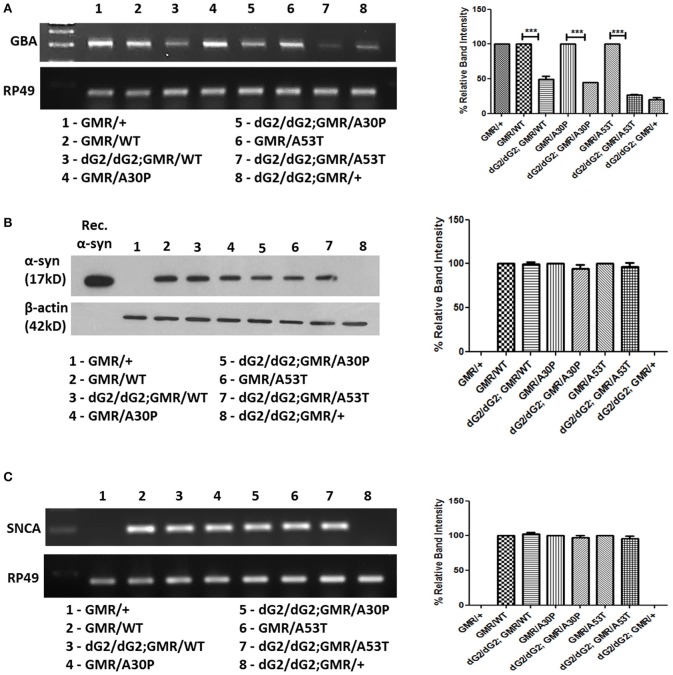
Absence of transcriptional changes in α-syn expression in dG2/dG2 RNAi flies. (A) RT-PCR confirms knockdown of GBA1 mRNA in flies with dG2/dG2 (in presence/absence of α-syn-WT, A30P, A53T) with single copy of GMR-Gal4 driver compared to respective control flies. This confirms significant transcriptional downregulation of GBA even in the absence of eye phenotype (in flies with single copy of GMR). Corresponding densitometric analysis of RT-PCR was done by normalizing controls to 100% and experimental flies (dG2/dG2 with/without α-syn) are compared against their respective controls. (B) The effect of GBA silencing on α-syn protein expression, immunoblotting was done by whole tissue lysis extraction method. Further densitometric analysis revealed no change in α-syn protein level in flies with dG2/dG2 expressing α-syn (WT, A30P, and A53T) under GMR-Gal4 drive compared to control flies expressing α-syn (WT, A30P, and A53T) alone. Corresponding densitometric graph where controls (GMR with/without α-syn) normalized to 100% is shown. (C) RT-PCR results show no changes in the transcriptional level of α-syn during GBA silencing. In densitometric analysis of α-syn RT-PCR, controls (GMR with/without α-syn) are normalized to 100% to compare experimental flies (dG2/dG2 with/without α-syn) against their respective controls. Graph represents mean ± S.E.M. for 3 independent experiments. Differences in means were compared by one-way ANOVA followed by the Newman-Keuls Multiple Comparison post hoc test. *** represents p < 0.0001.